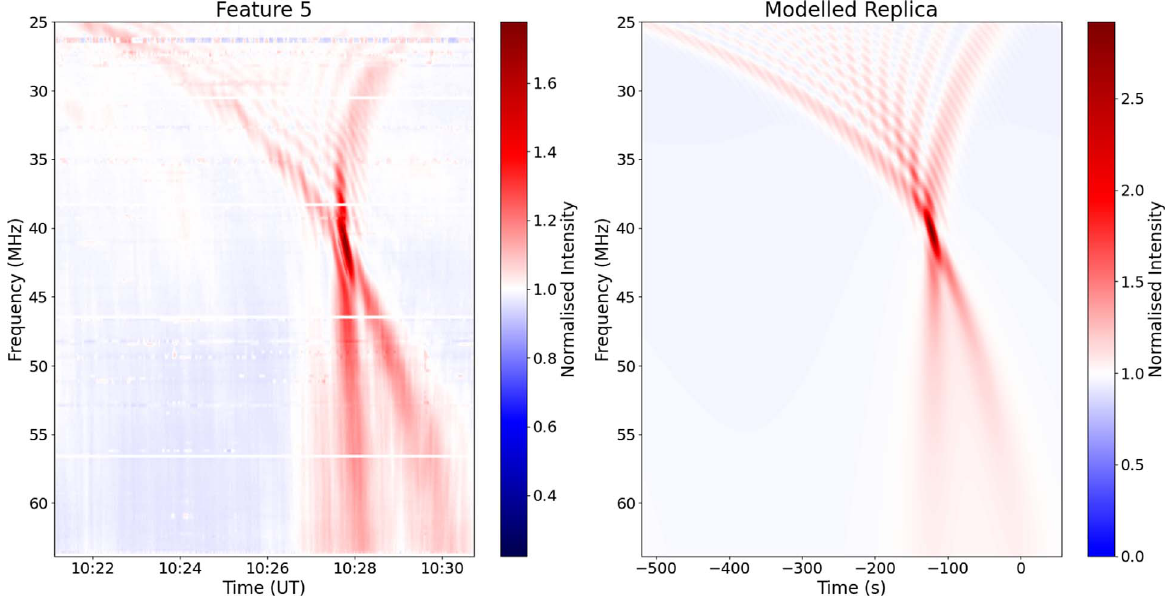
Fig. 8. Feature 1 and its modelled replica. Both plots use the same time scale and t = 0 corresponds to the TID minimum lying on the line of sight (note that different colour scales are used in each panel). The parameters used here are: U 0 = 1.1 (cid:2) 10 9 rad Hz, K = 30 km, h = 5 (cid:3) , a